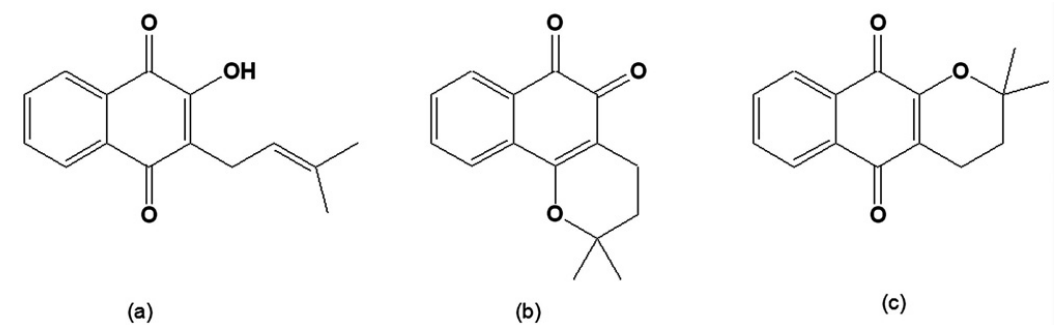
Figure 1. (a) 2-Hydroxy-3-(3´-methyl-2-butenyl)-1,4-naphthoquinone [lapachol]; (b) 2,2- Dimethyl-3,4-dihydro-2 H -benzo[ h ]chromene-5,6-dione [ β -lapachone]; (c) 2,2-Dimethyl- 3,4-dihydro-2H-benzo[g]chromene-5,10-dione [ α